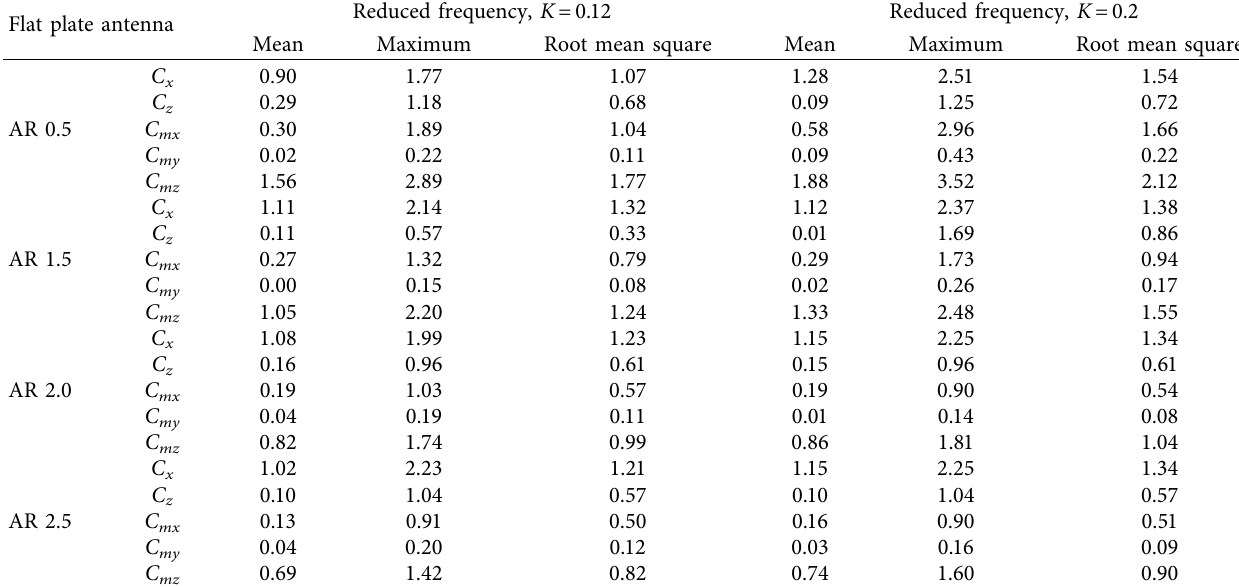
Table 2: Mean, maximum, and root mean square values of aerodynamic coefficients with respect to the aspect ratio during a single rotation period. AR, aspect ratio. (Values represent magnitude only, not direction). Flat plate